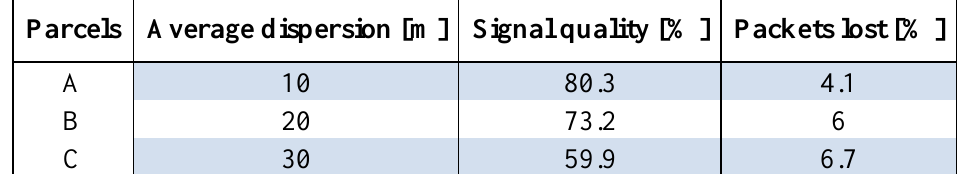
Table 1. Signal quality and packets lost during the remote sensing mission for each cluster.